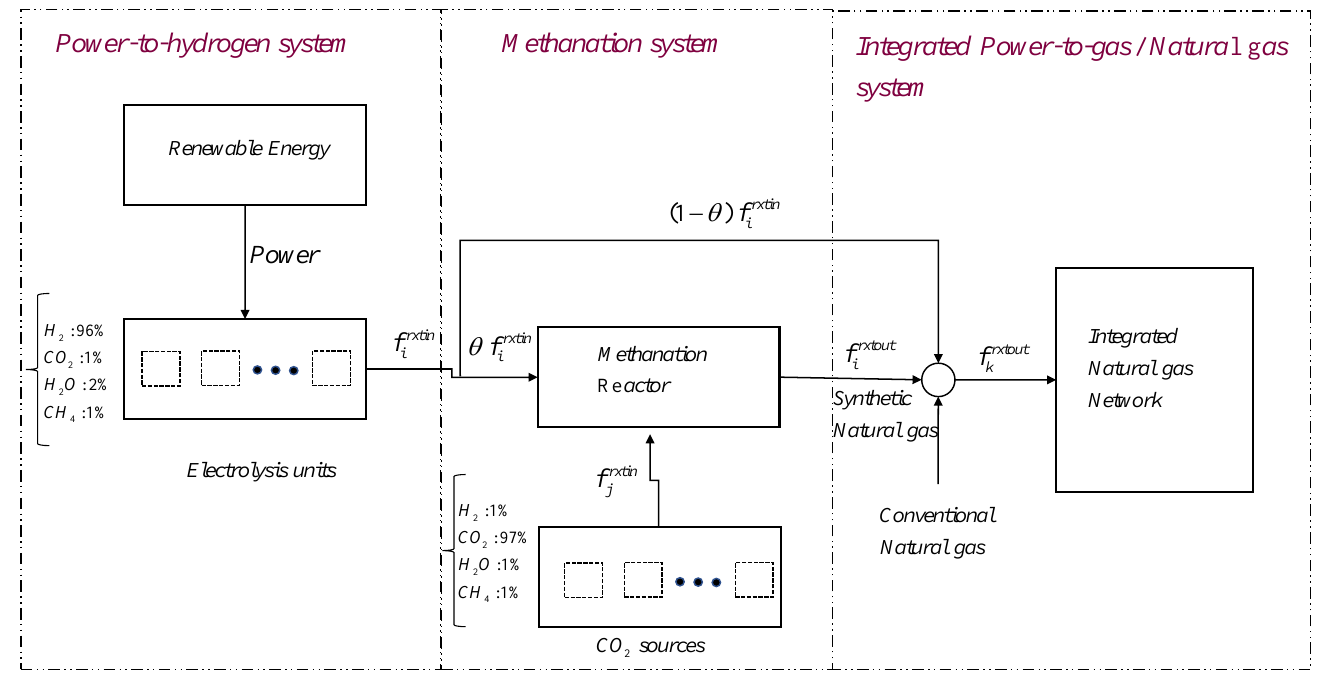
Figure 3. Process description for combined methanation and hydrogen injections. The integrated system model optimizes both the design and operational decisions. Binary decision variables are used to model design decisions which include whether or not to include electrolyser/hydrogen stations, CO 2 sources, natural gas sources, blending or distribution units and connections between them, while continuous variables model the operational variables consisting of flow rates and pressures at the different nodal locations and at the units/pipeline connections. The binary variables given by y , y , y , y and e c n m y denote the nodes for electrolysis, CO 2 , natural gas, blending and distribution units, d respectively, while y , y , y , y , y , y , and y denote the design connections e , r c , r r , m n , m n , d m , m (cid:48) m , m (cid:48) between the different sources to blending, and blending points to distribution